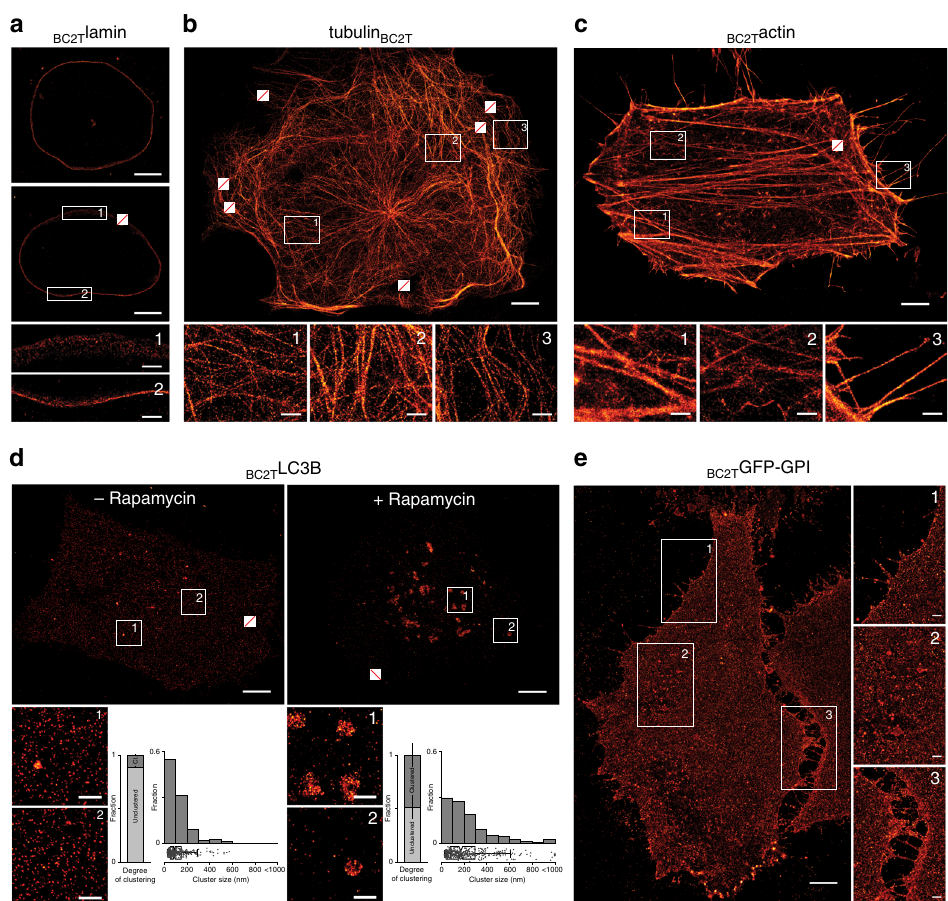
Fig. 3 Super-resolution imaging of transiently expressed BC2-tagged proteins in chemically fi xed cells. Representative dSTORM images of a a HeLa cell expressing BC2T lamin, b U2OS cell expressing tubulin BC2T ( fi lament width statistics in Supplementary Fig. 9a), c HeLa cell expressing BC2T actin (coverage statistics in Supplementary Fig. 9b), d HeLa cells expressing BC2T LC3B either left untreated or treated with rapamycin. Bar charts represent the degree of clustering, given as a relative fraction of cluster points versus noise points, errors given as standard deviation (S.D.). Histograms represent cluster diameters as determined by DBSCAN analysis with a bin size of 100 nm ( x- axis) plotted against relative fraction ( y- axis). Full data are represented underneath the histograms as box + scatter plots with the same x- axis. The box marks the three quartiles and the whiskers mark 95% of all the data. Total number of clusters n = 342 in non-treated cells, n = 405 in treated cells, N = 3 cells for untreated cells and N = 4 cells for rapamycin-treated cells (Supplementary Fig. 11), and e HeLa cells expressing BC2T GFP-GPI. All cells were stained with bivBC2-Nb AF647 (Methods section). Scale bars, images 5 µ m, insets 1 µ m. Crossed out rectangles mark the position of fi ducial markers used for drift correction. Image reconstruction details are given in